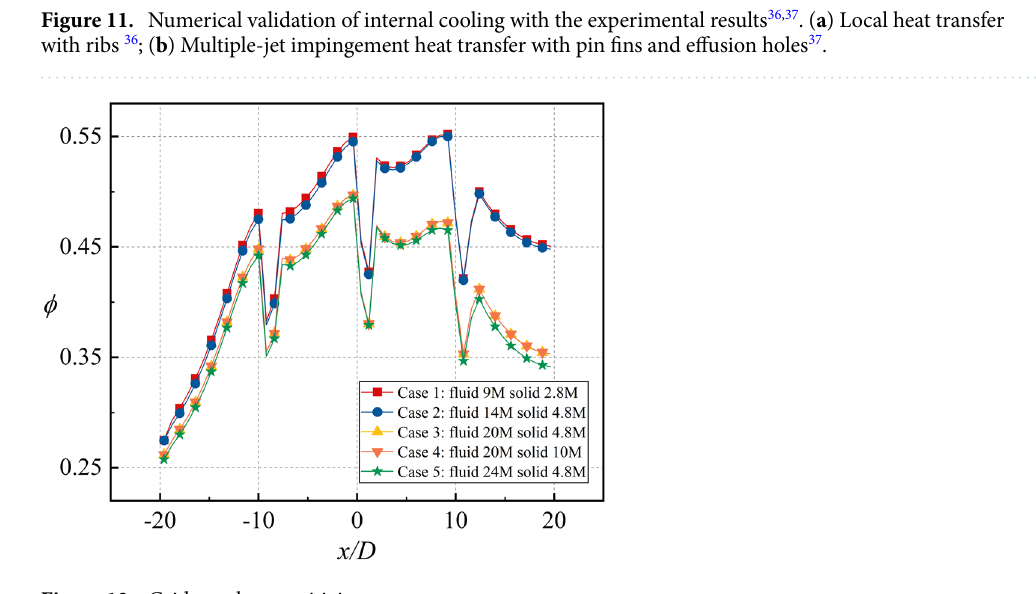
Figure 12. Grid number